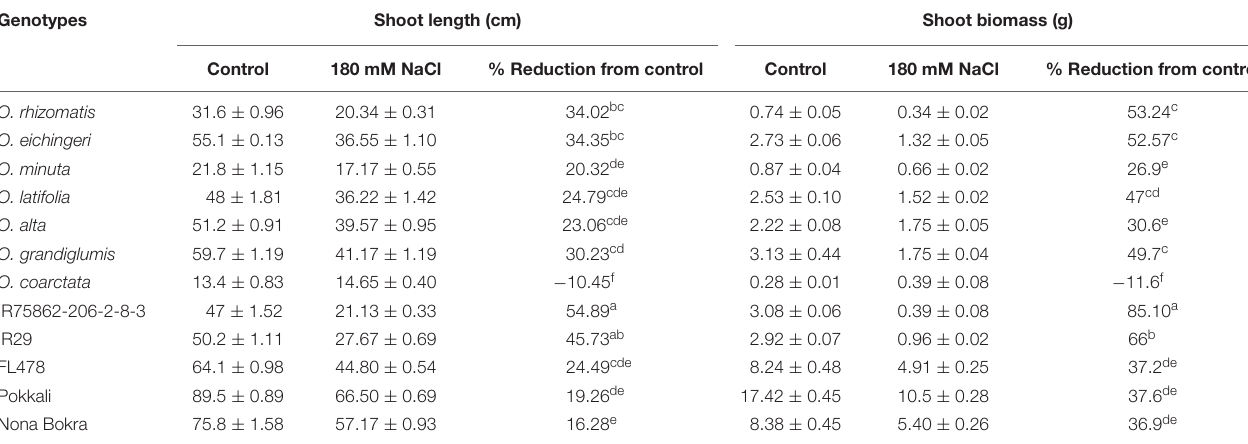
The data represented are mean values (n = 5) with standard errors. Different letters in the % reduction coulmn are statistically different as inferred from DMRT at p < (0.05).